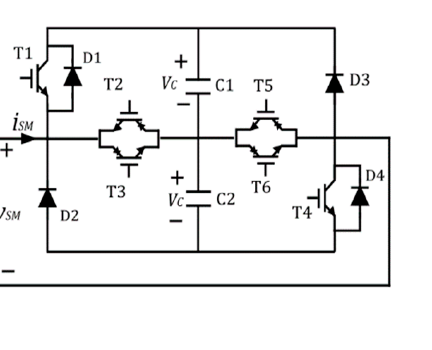
Figure 19. DRBSM 438 Figure 19. DRBSM.